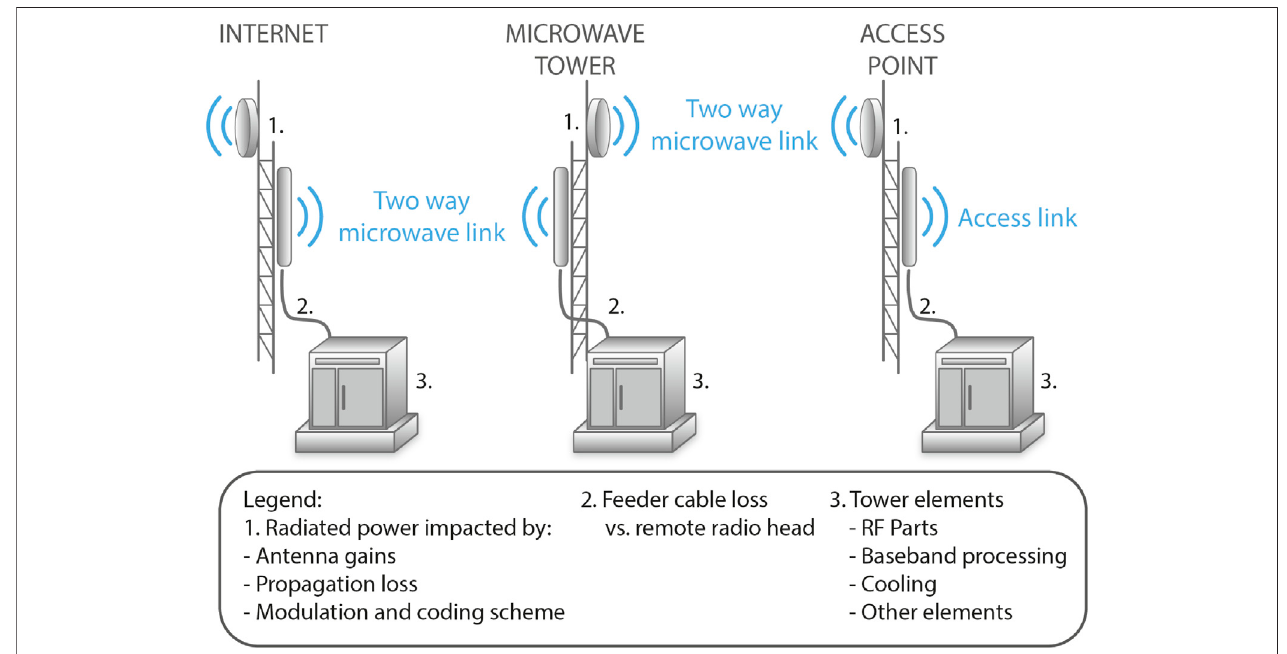
FIGURE 6 | Power consumption points in a backhaul chain connected to an access point.